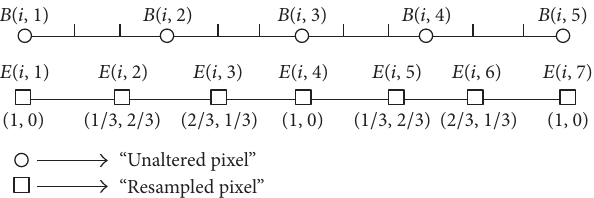
Figure1:Exampleoftheupscaling( 𝑠 = 3/2 ,bilinear)processforthe 𝑖 th row of image B (the first line). The corresponding interpolated weights are shown in the